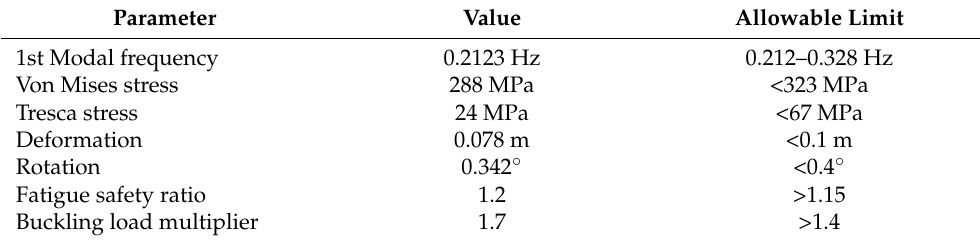
Table 2. Structural behavior of the optimized support structure